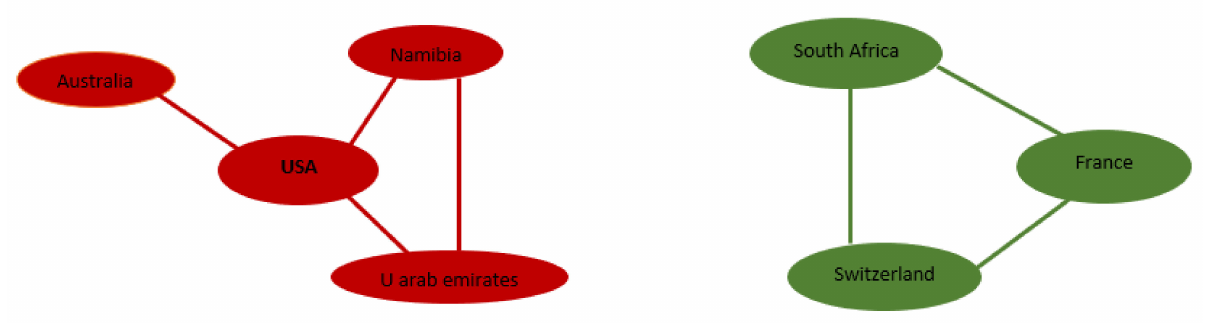
Figure 3. The country collaboration network derived from African published documents.